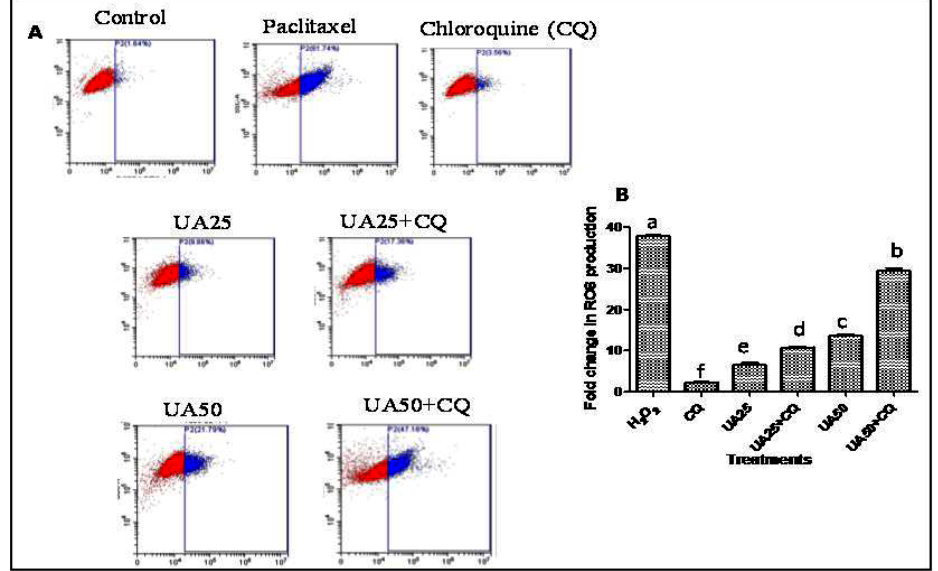
Figure 7. Effect of UA on reactive oxygen species (ROS) production in HeLa cells in the presence of chloroquine (+/ − CQ) via DCFHDA FACS analysis after 24 h of treatment. ( A ) FACS plot of UA-treated (+/ − CQ) HeLa cells. ( B ) The bar graph shows the fold-change in ROS production after UA treatment (+/ − CQ). Values are the means ± SD of three independent experiments. Means sharing different letters differ significantly from each other at p ≤ 0.05. The blue color represents ROS generating cells, while red color represents healthy cells which are not producing ROS.